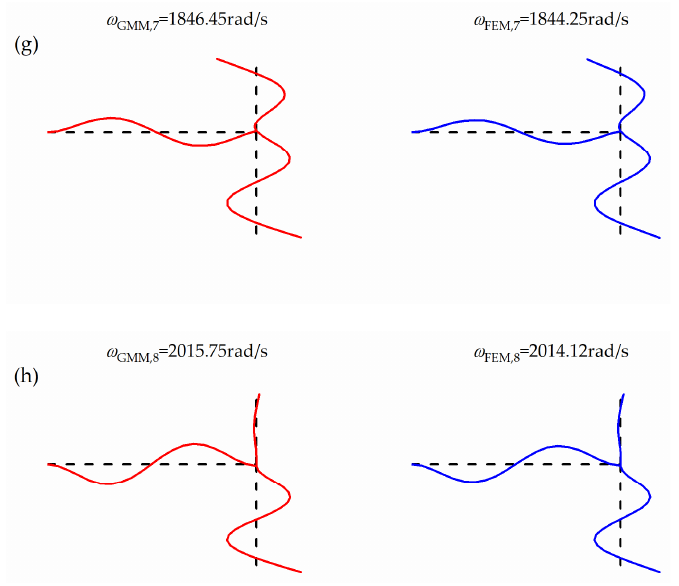
Figure 3. First 8 order modal shapes: GMM (Left column) and FEM (Right column).